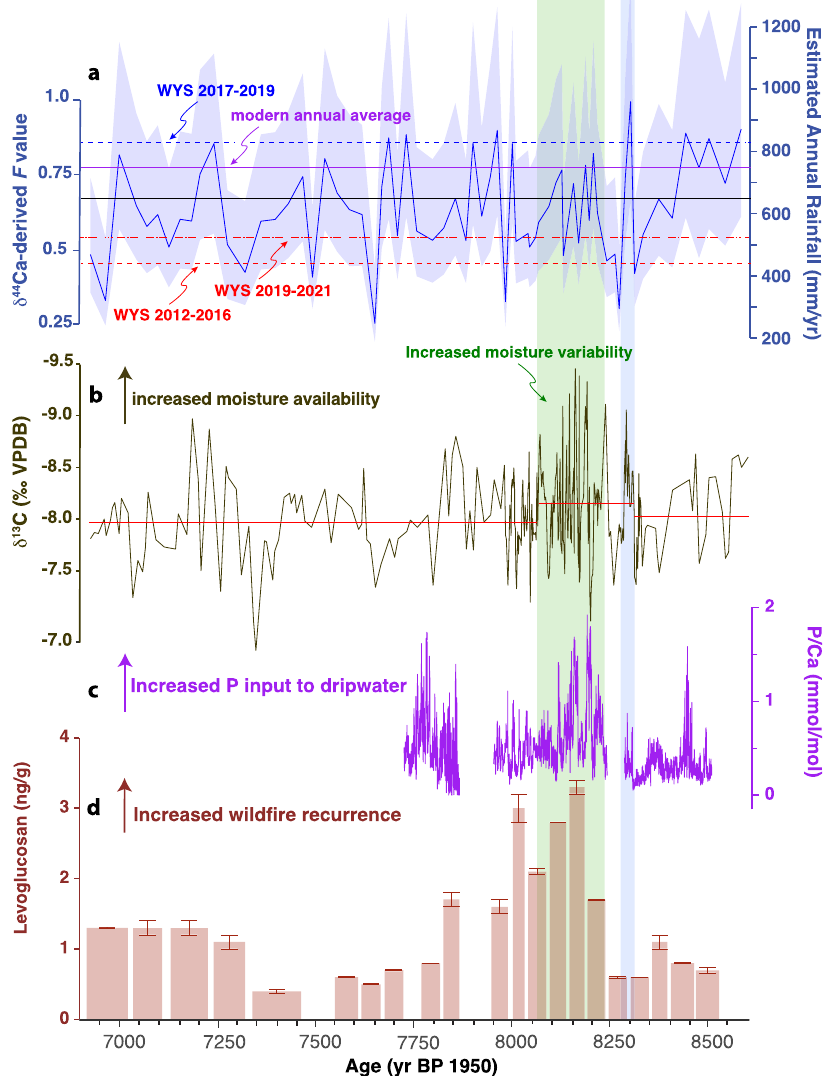
Fig. 1 | Proxy records for White Moon Cave (WMC) stalagmite. a Fraction of calcite remaining in solution (F) computed from speleothem δ 44 Ca using Rayleigh fractionation model 15 and translated to estimated rainfall using modern cave sys- tem δ 44 Ca values and modern rainfall. Horizontal lines provide a comparison to rainfall amounts in the last decade: Wys (water years; 12-month period from 1 October to 30 September designated by the calendar year in which it ends) 2012 – 2016 (red dashed, 58% modern); Wys 2017 – 2019 (blue dash-dot, 109%